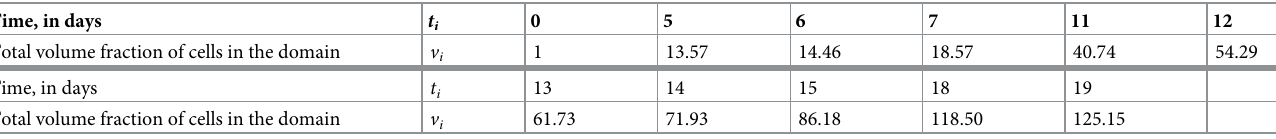
Table 5. Tumor size data set 2. Scaled down from the clinical results in [6].